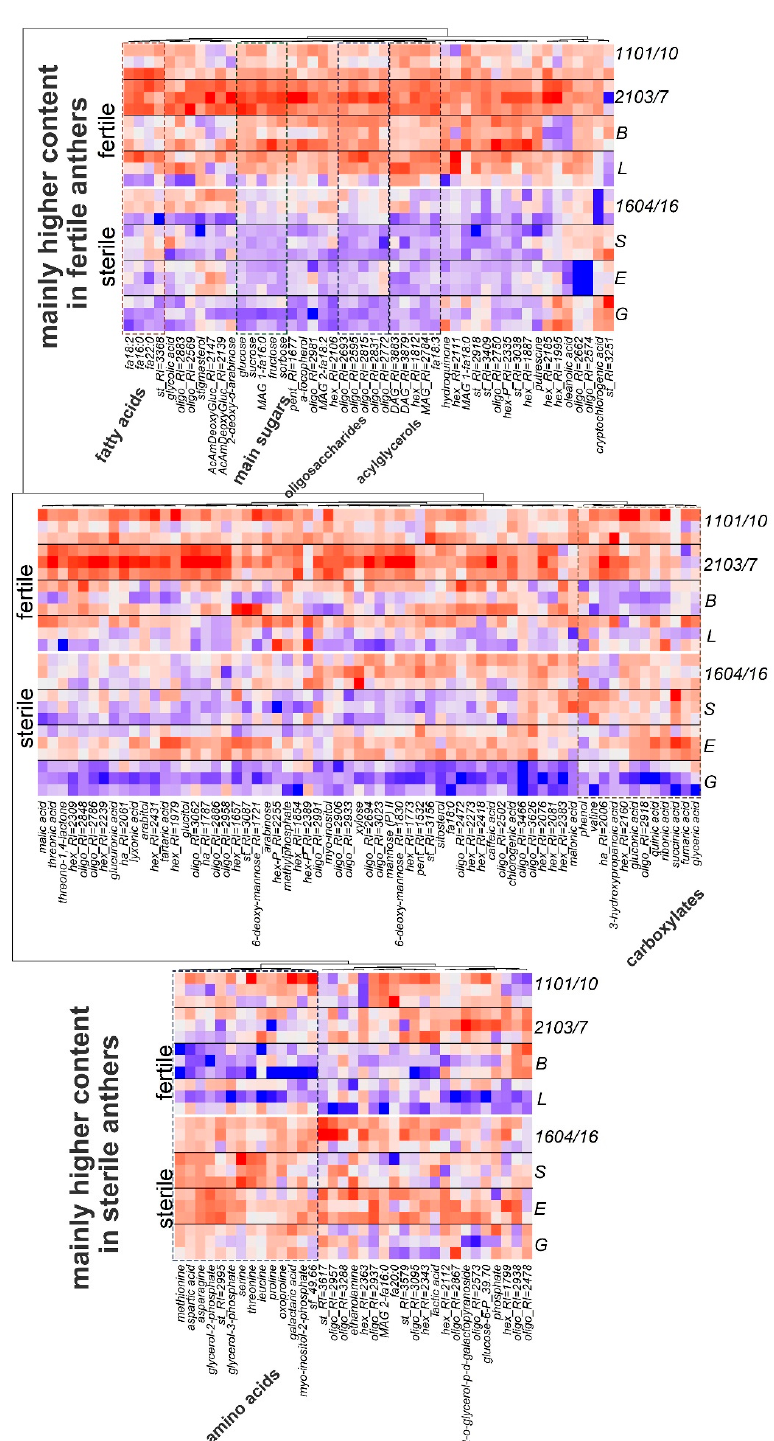
Figure 3. Heat map visualization of the content of identified metabolites in anthers at the mature pollen stage from fertile and sterile potato genotypes. This was combined with HCA (hierarchical cluster analysis) using correlation as distance (1-r) and the Ward method for cluster agglomeration. Data was standardized with red–higher content, blue–lower.